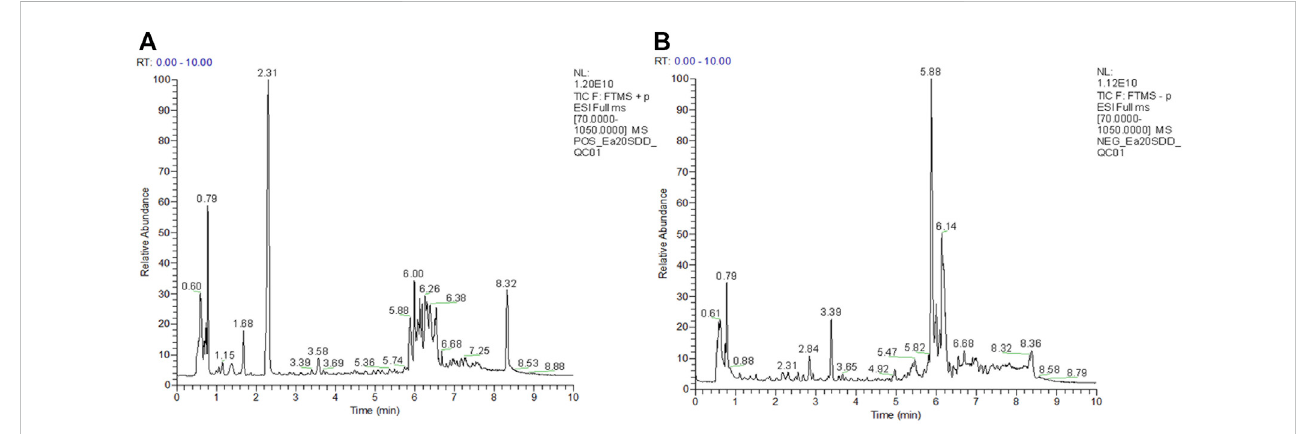
FIGURE 4 Typical chromatograms of positive and negative modes. (A) UPLC-QE ESI(+) total ion current diagram of quality control, (B) UPLC-QE ESI( − ) total ion current diagram of quality